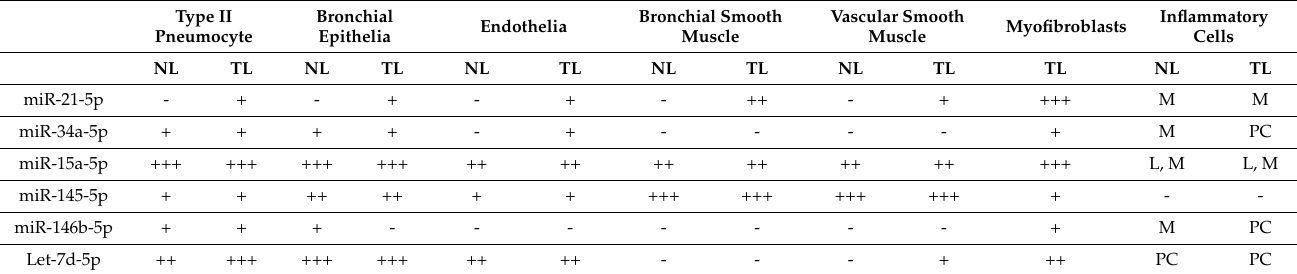
Figure 1. Tissue localization of miRNAs in normal lung (miR-21-5p ( a ); miR-146b-5p ( c ); miR-34a-5p ( e ); miR-15a-5p ( g ); miR-145-5p ( i ); let-7d-5p ( k )) and BOS samples (miR-21-5p ( b ); miR-146b-5p ( d ); miR-34a-5p ( f ); miR-15a-5p ( h ); miR-145-5p ( j ); let-7d-5p ( l )) by ISH. Table 2. topographic and semi quantitative evaluation of miRNAs with in situ hybridization (ISH).